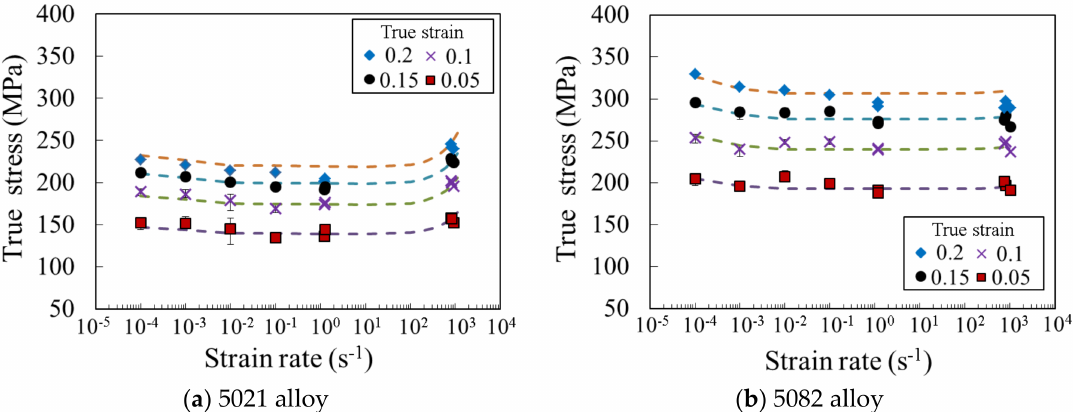
Figure 7. Stress and strain rate relationship of ( a ) 5021 and ( b ) 5082 aluminum alloys. Curves indicated by dashed line were obtained from Equation (8).